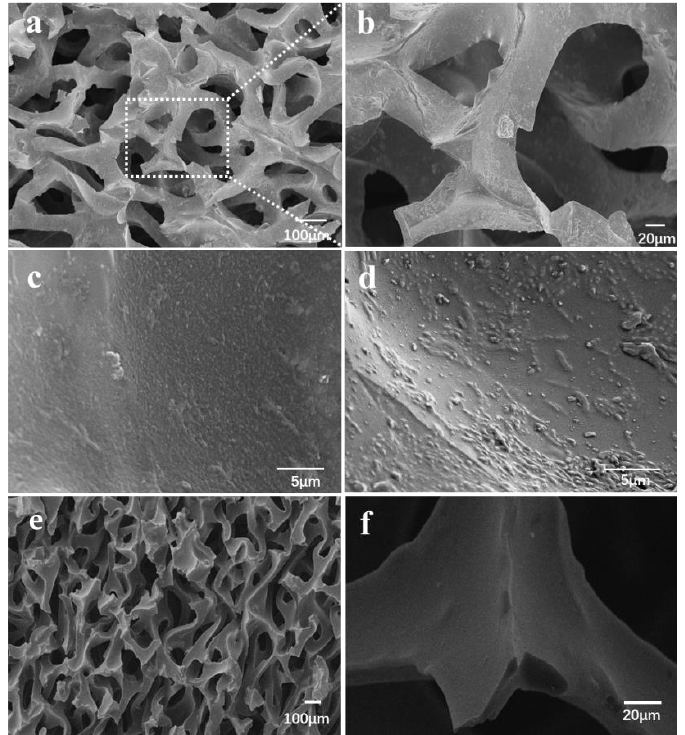
Figure 4. The distribution of S. loihica PV-4 biofilm on RVC electrode surface at 96 h after inoculation with electrode potentials 0.24 V ( a , b , c ) and 0 V ( d ). Biofilm formation is more evident at 0.24 V. Clean RVC at different magnifications is included for comparison ( e , f ).